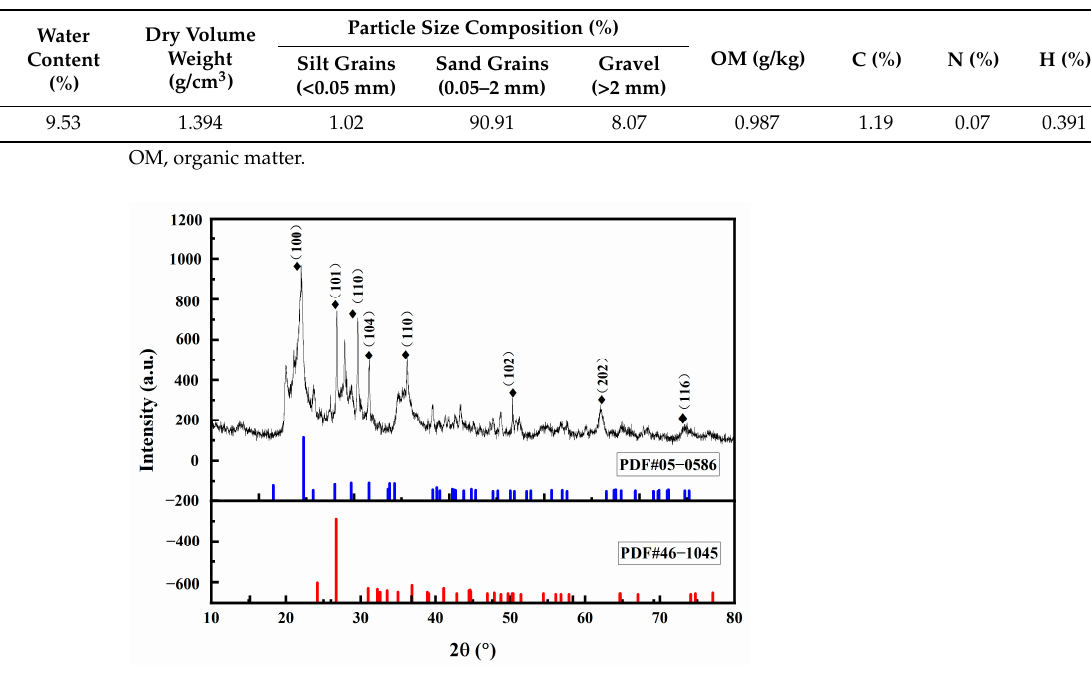
Table 2. Basic physicochemical properties of the marine sediments.